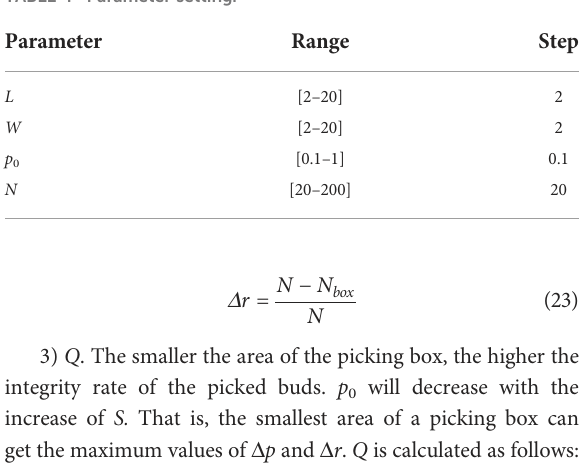
TABLE 4 Parameter setting.